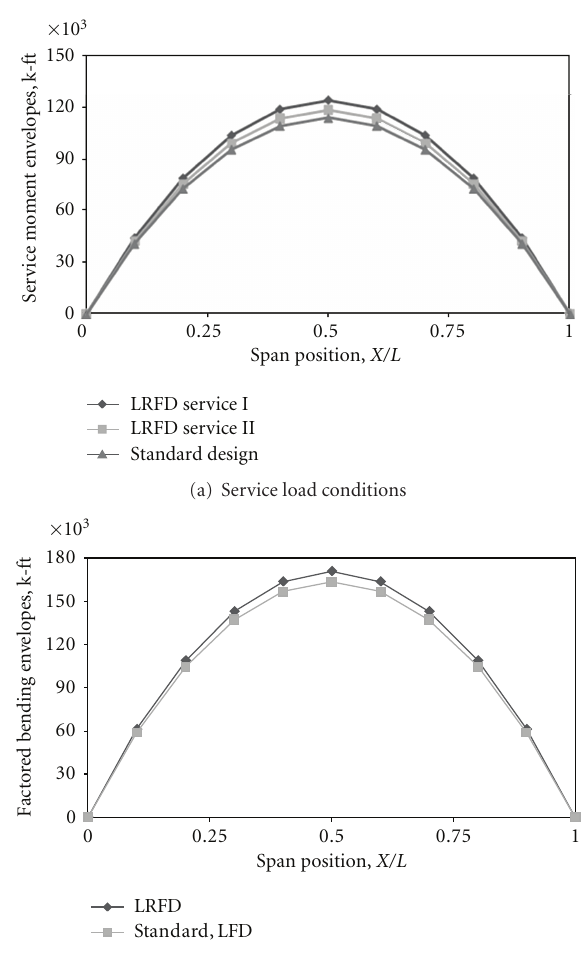
Figure 2: Comparison of moment envelopes for 180 ft single-span box girder with eight webs spaced at